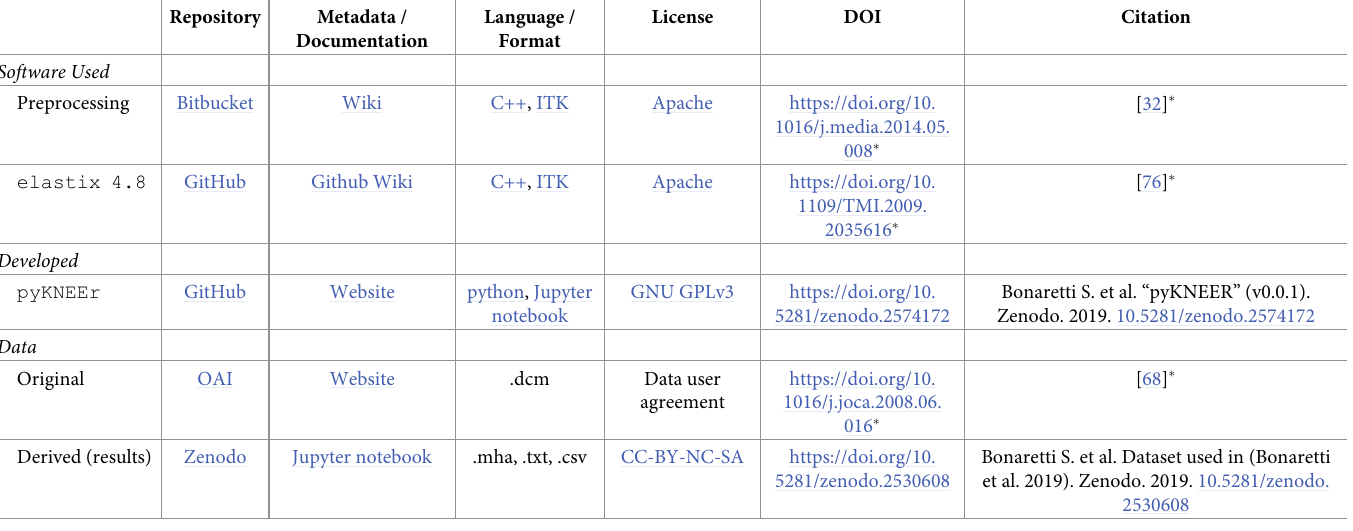
Fig 1. Literature map of femoral knee cartilage segmentation. The visualization shows name of first author, year of publication, affiliation of last author, and segmentation method for 29 relevant publications on femoral knee cartilage segmentation from 1997 to 2018. Publications by segmentation method and in alphabetical order are: Active contours: Amberg(2010) [39], Carballido-Gamio(2008) [40], Solloway(1997) [41], Vincent(2011) [42], Williams(2010) [43]; Atlas- based: Pedoia(2015) [44], Shan(2014) [32], Tamez-Pena(2012) [45]; Deep-learning: Liu(2018) [46], Norman(2018) [47], Prasoon(2013a) [48], Zhou(2018) [49]; Graph-based: Bae(2009) [50], Ozturk(2016) [51], Shim(2009) [52], WangP(2016) [53], Yin(2010) [54]; Hybrid: Ambellan(2018) [55], Dam(2015) [56], LeeJG (2014) [57], LeeS(2011) [58], Seim(2010) [59], WangQ(2013) [31], WangZ(2013) [60]; Machine learning: Folkesson(2007) [61], Liu(2015) [62], Pang(2015) [63], Prasoon(2013) [64], Zhang(2013) [65]. This graph and graphs in Figs 4 and 5 were made in Jupyter notebook using ggplot2 [66], an R package based on the grammar of graphics [67]. (See data, code, executable environment). https://doi.org/10.1371/journal.pone.0226501.g001 Table 1. Openness and reproducibility of pyKNEEr code and experimental